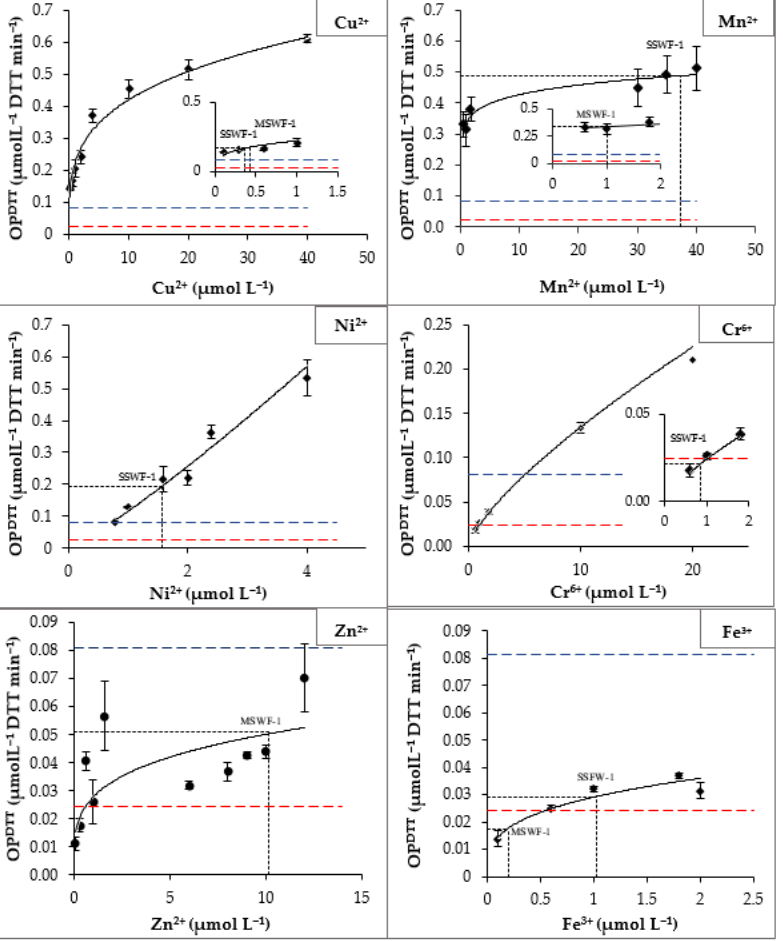
Commented [M43]: 1. Please change hyphen to minus sign in the units, for example, min -1 should be min − 1 2. In the subfigure of Fe 3+ , please add a space between the units of X-axis.